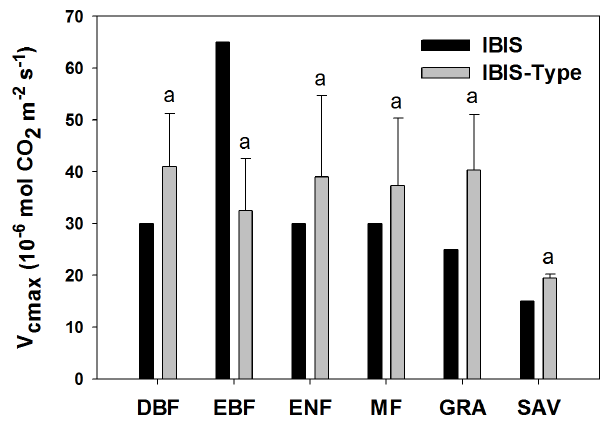
Figure 3. Comparison of V cmax from the original scheme and the inversed V cmax values. Comparison of model V cmax values with the inversed values of the IBIS-Type. Same letter on the top of the bar indicates no significant difference among biomes.